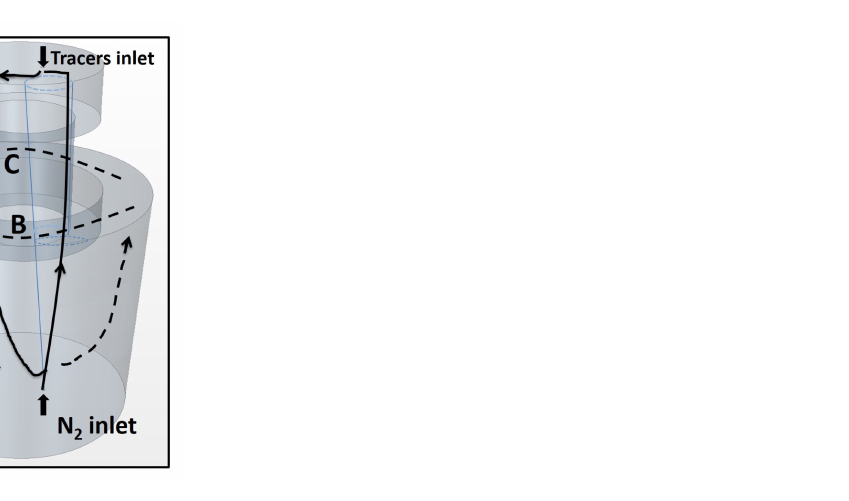
Figure 8. Schematic diagram of transport process of tracers in the water model of SSRF (Three paths are denoted A, B and